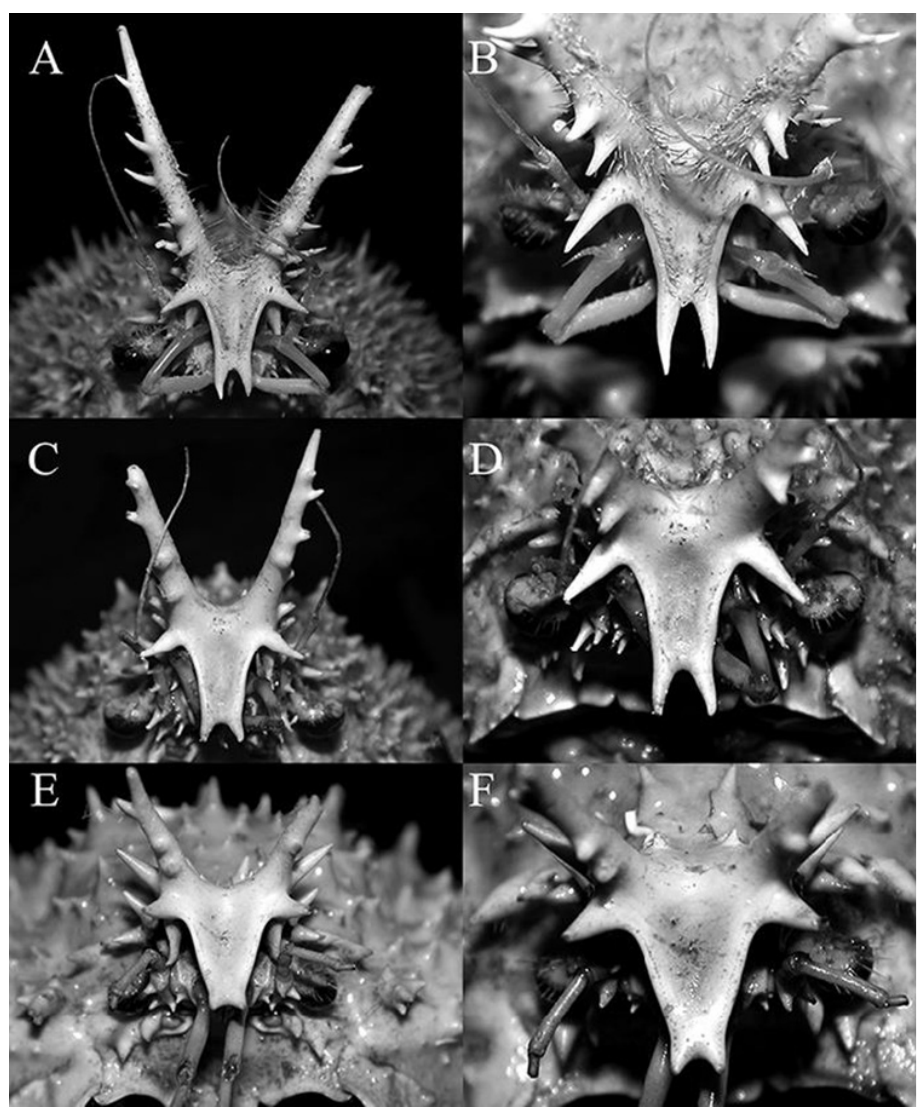
Figure 6. A, B Pleistacantha moseleyi (Miers, 1885), male (cl 82.5 mm, cw 61.6 mm) (ZRC 2005.117), Philippines C, D Pleistacantha pungens (Wood-Mason, in Wood-Mason & Alcock, 1891), male (cl 94.0 mm, cw 67.6 mm) (ZRC 2016.23), Myanmar E, F Pleistacantha kannu sp. n., holotype male (cl 106.2 mm, cw 87.0 mm) (CASAU),